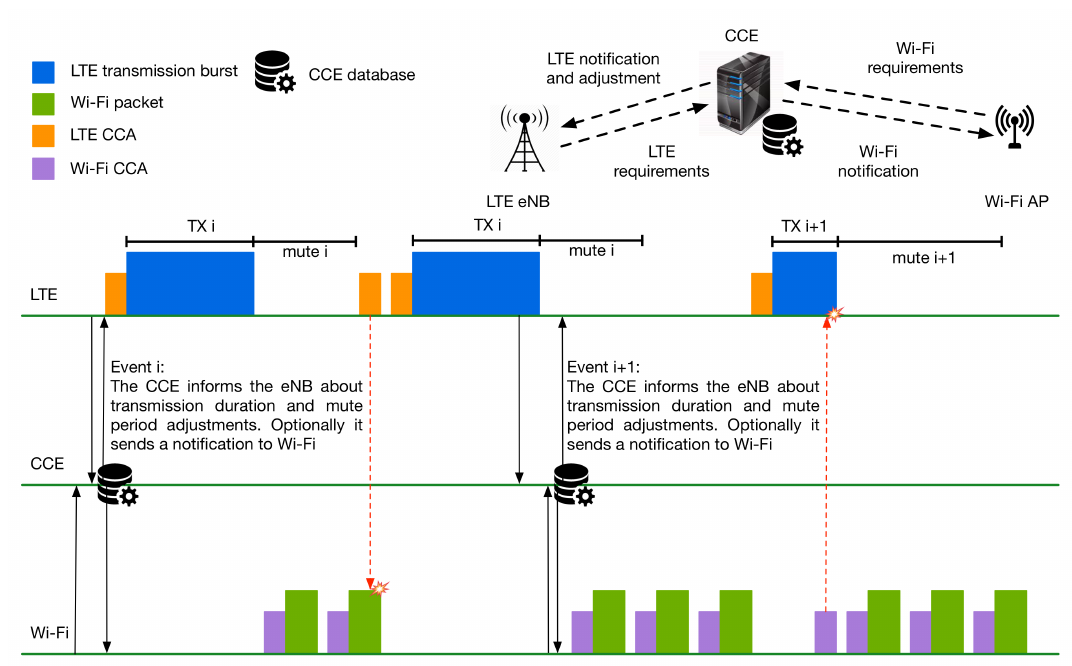
Figure 13. Adjustment of LTE and Wi-Fi transmission based on requirements and